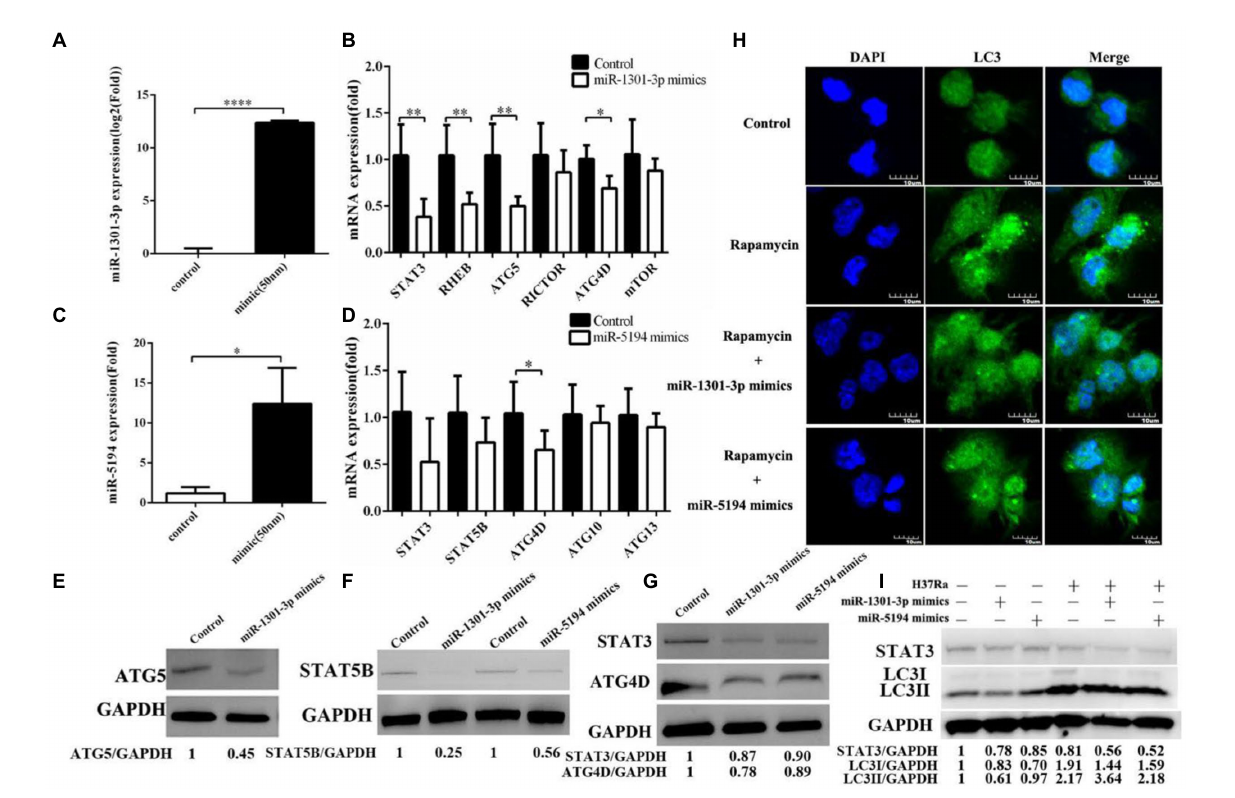
FIGURE 4 miR-1301-3p/miR-5194 inhibited autophagy. (A–D) THP-1 cells were transfected with miR-1301-3p mimics (A) or miR-5194 mimics (C) for 24 h, and mRNA levels were measured using qRT-PCR (B) potential targets of miR-1301-3p, (D) potential targets of miR-5194). (E–G) THP-1 cells were transfected with mimics of miR-1301-3p/miR-5194 for 48 h and proteins associated with autophagy-related 5 (ATG5) (E) , signal transducer, and activating transcription 5B (STAT5B), (F) STAT3 and autophagy-related 4D cysteine proteinase (ATG4D) (G) were detected by Western blotting. (H) The THP-1 cells were stimulated with PMA and then transfected with miRNA invalid fragments (control) or miR-1301-3p/miR-5194 mimic for 24 h. Afterward, rapamycin was added for 2 h. The microtubule-associated protein 1A/1B light chain 3 (LC3) puncta were tracked with antibodies followed by fluorescein isothiocyanate (FITC)-conjugated IgG. The pictures were captured at a magnification of 600. (I) The THP-1 cells were stimulated with PMA and transfected with miR-1301-3p/miR-5194 mimics for 24 h and further infected with H37Ra for 24 h. Both STAT3 and LC3 proteins were measured using Western blotting. Data represent the mean ± SD from three replications. A two-tailed Student’s t -test was used for statistical analysis. * p < 0.05, ** p < 0.01, and **** p <